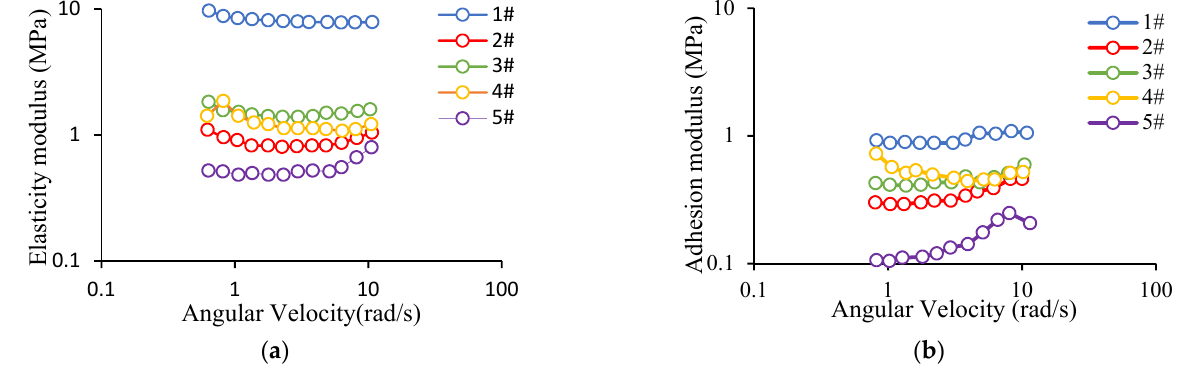
Figure 2. Rheological measurement results. ( a ) The relationship between elastic modulus and angular velocity. ( b ) The relationship between viscous modulus and angular velocity.